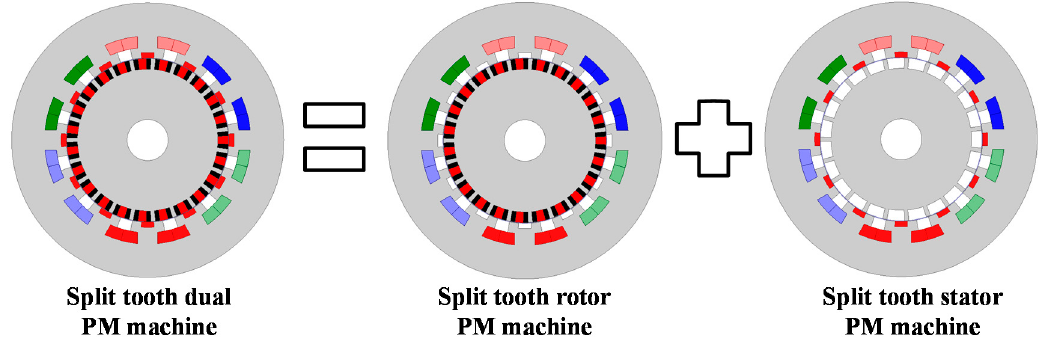
Figure 3. Machine decomposition of 12S23R1Pa STDPM machine.